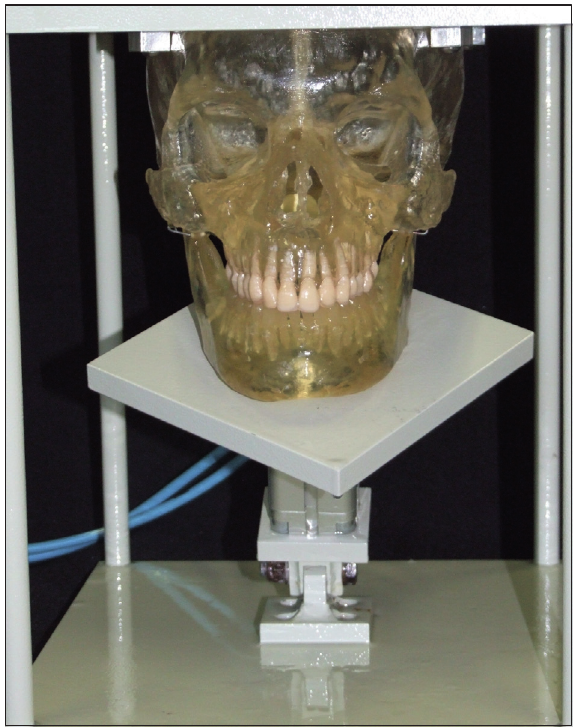
Figure 1 - Photoelastic